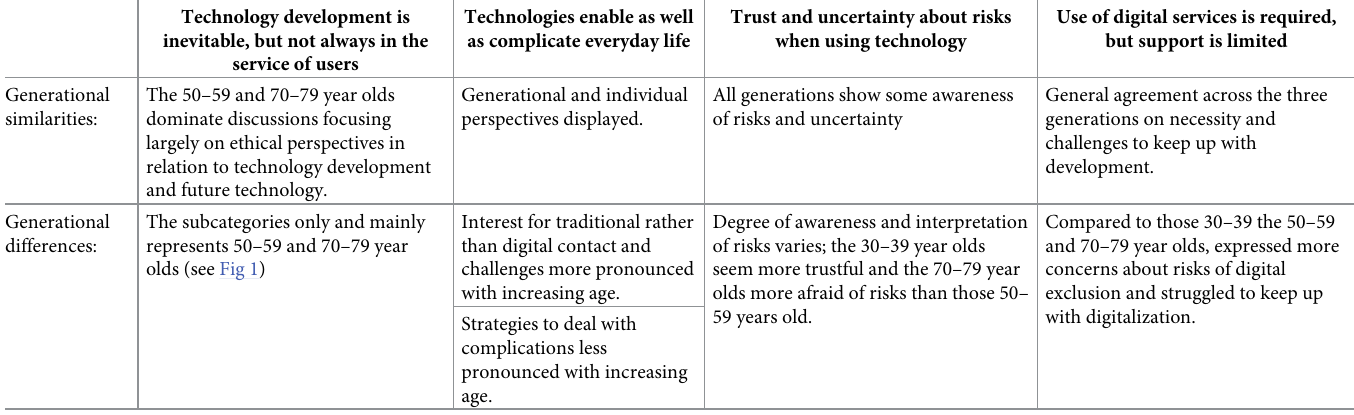
Table 2. Overview of generational similarities and differences in the categories. Technology development is inevitable, but not always in